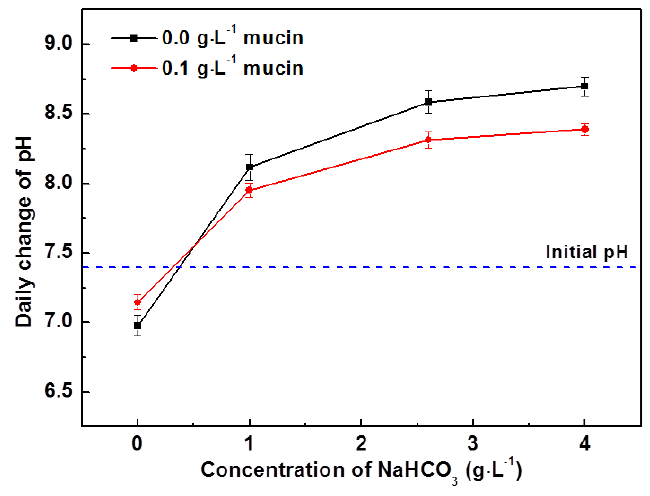
Figure 2. Daily pH change of modified Gamble’s solutions with different concentration of and mucin during immersion of AZ31 magnesium alloys ( n = NaHCO 3